Question: Provide a one-line summary of what is displayed.
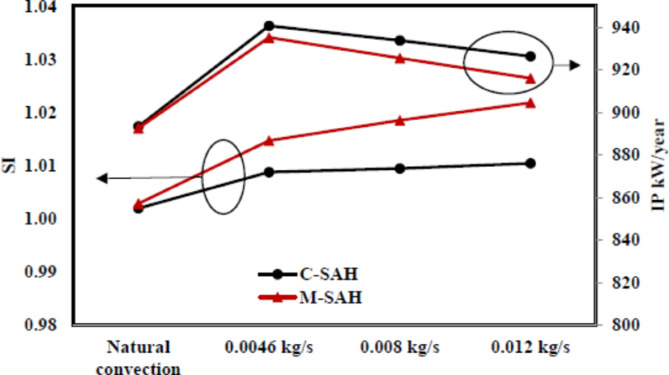
Answer: Variation of SAH sustainability index (SI) and improvement potential (IP) for C-SAH and M-SAH under natural and forced convection operating conditions.